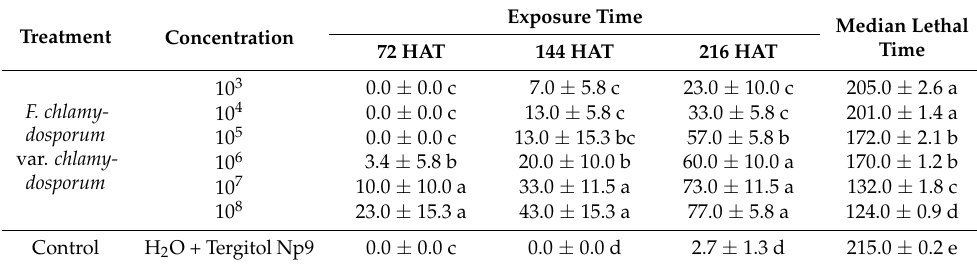
Table 4. Mean mortality ( ± sd) and Median Lethal Time of H. armigera adults exposed to F . chlamy- dosporum var. chlamydosporum for 216 h of two season experiments. Means of the same column followed by the same letter are not significantly different (Tukey test, a = 0.05), Median Lethal Time (hours ± sd) was estimated by the Kaplan–Meier method (F = 4.115, df = 6, p < 0.001), HAT: Hours After Treatment.